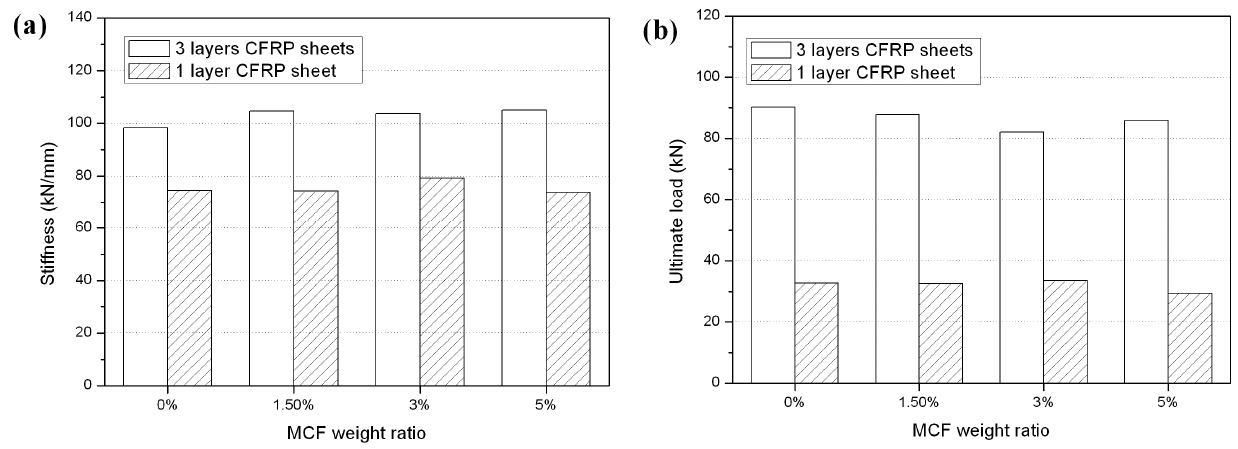
Figure 6. Comparison of ( a ) stiffness; and ( b ) ultimate load of DJS specimens with different MCF weight